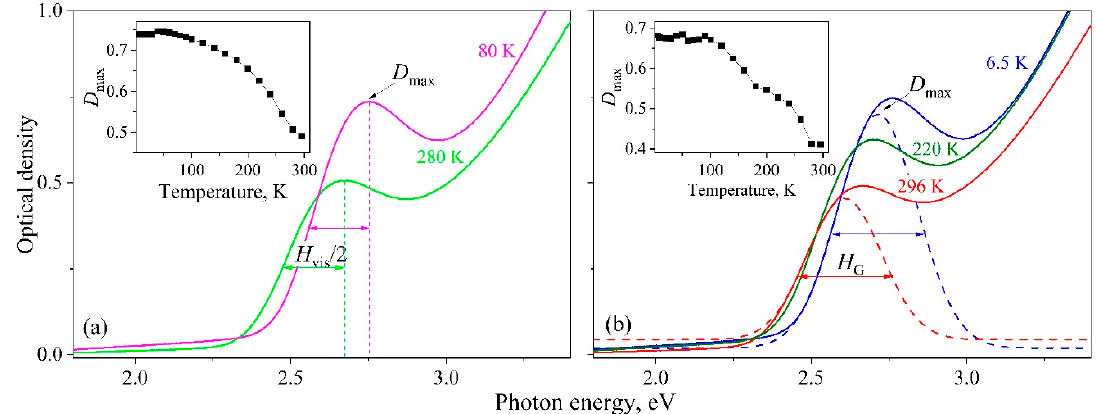
Figure 1. Temperature behavior of the first exciton absorption band in InP / ZnS quantum dots. The estimation of the H vis ( a ) and H G ( b ) band half-widths is demonstrated. The dashed line shows the approximation by the Gaussian band. The insets show the changes in optical density at the maximum of the exciton band. The experimental data shown were obtained in our early study [22].